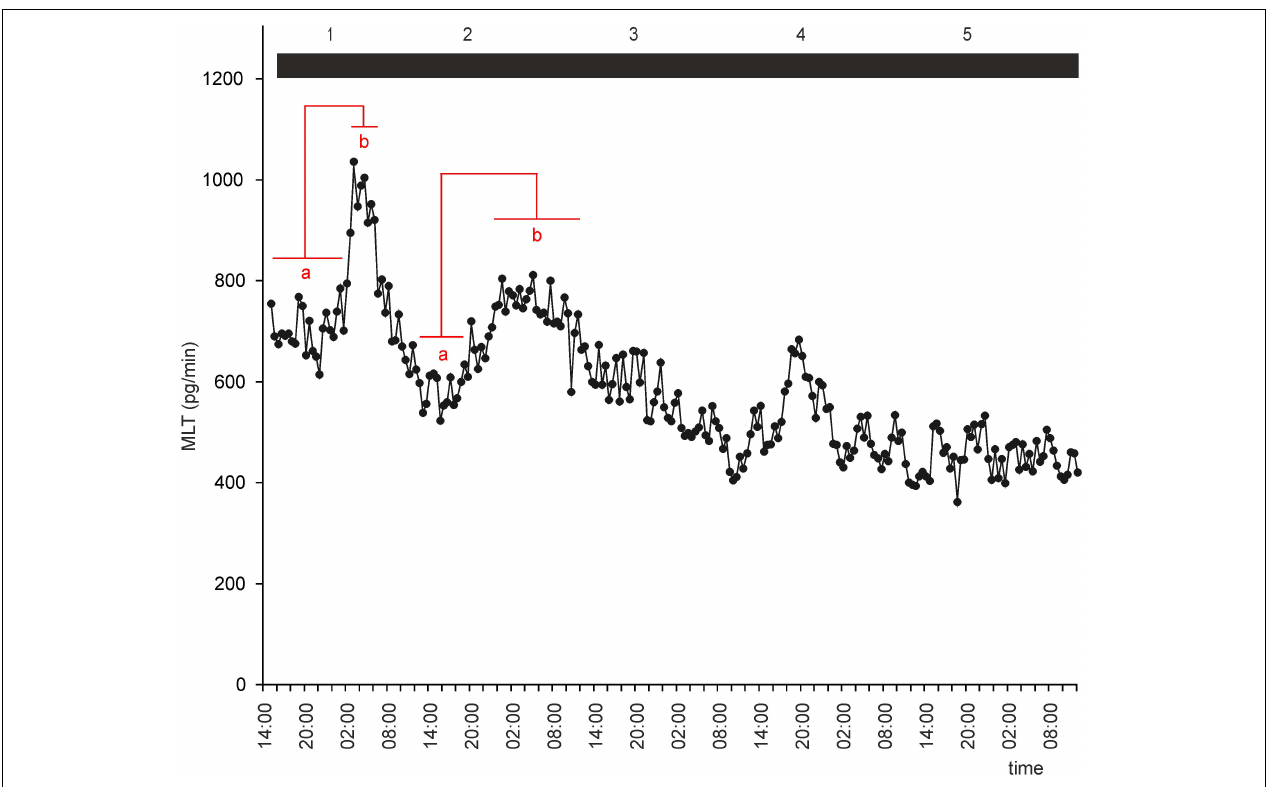
FIGURE 4 | Secretion (means, n = 4) of MLT by goose pineal organs incubated in continuous darkness for 5 days. Horizontal red lines show periods, when the means differ significantly ( p < 0.05) between sampling time-points (repeated measures ANOVA and LSD